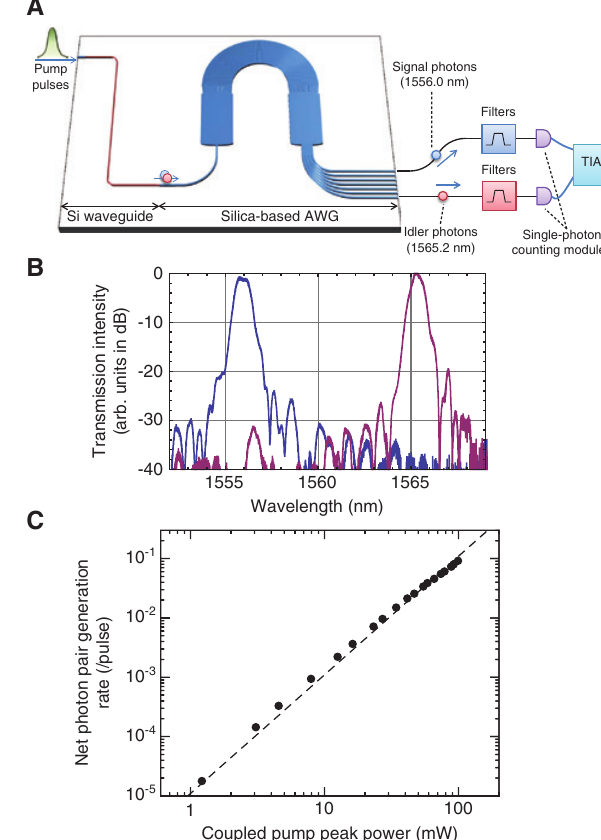
Figure 13: (A) A chip housing a silicon waveguide photon pair source and a silica-based AWG, illustrated with the experimental setup. (B) Transmission spectra from the on-chip AWG output